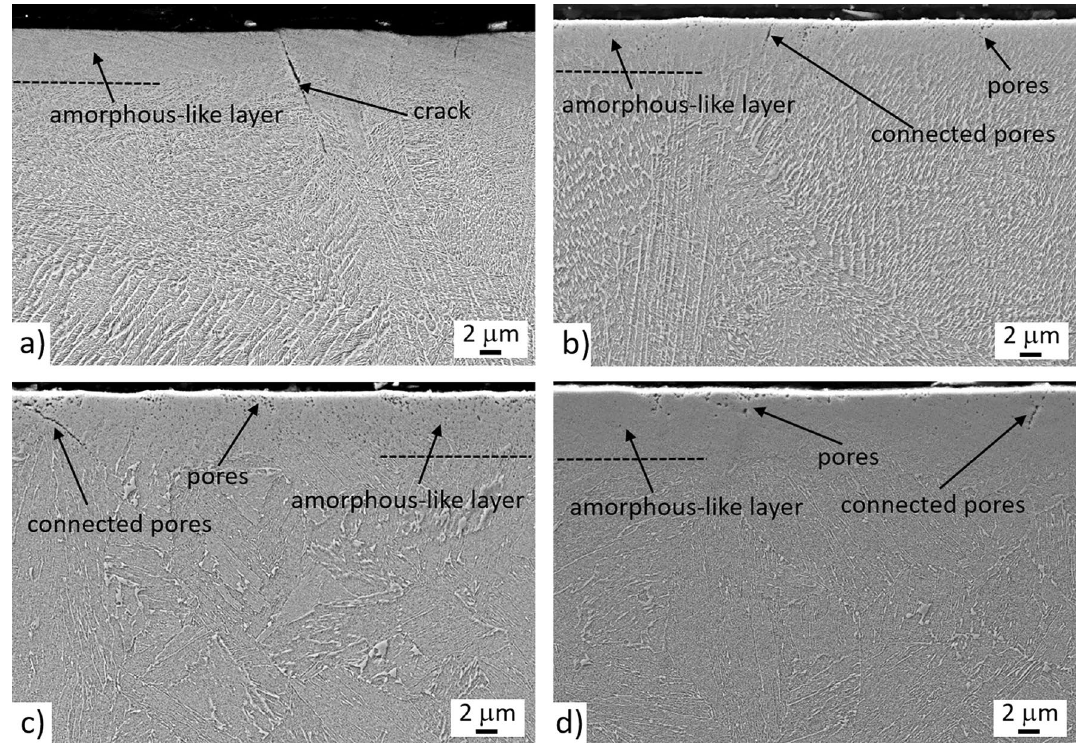
Figure 3. SE images of nitride layer for the investigated samples: ( a ) AM + N, ( b ) AM + DAT + N, ( c ) AM + SAT + N, ( d ) CM + SAT + N; etched in